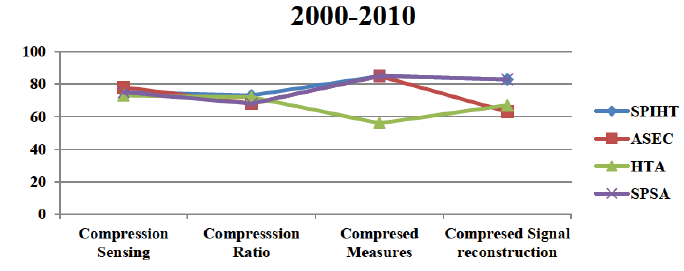
Figure 1: Graphical representation of 2000-2010 review papers